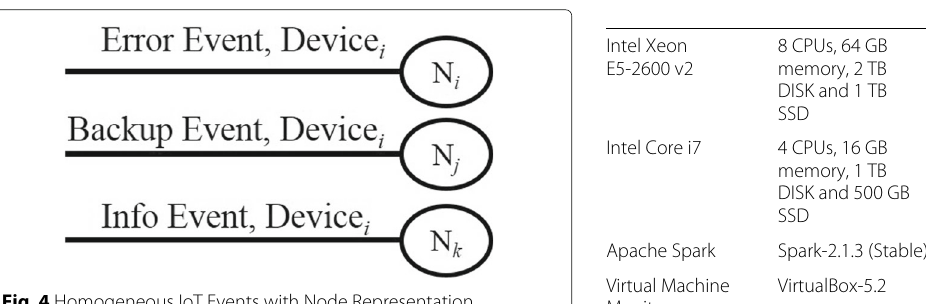
Fig. 4 Homogeneous IoT Events with Node Representation